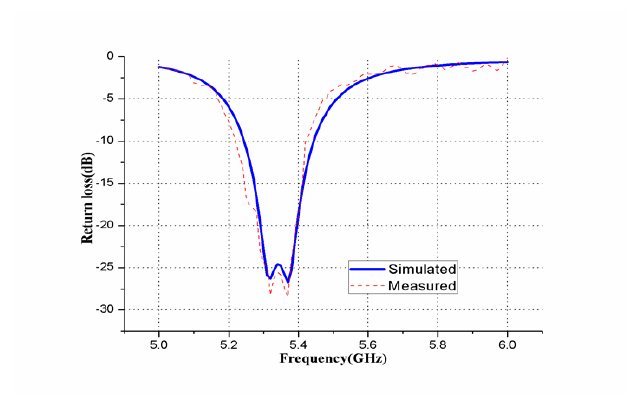
Fig. 5. The return loss of the antenna.